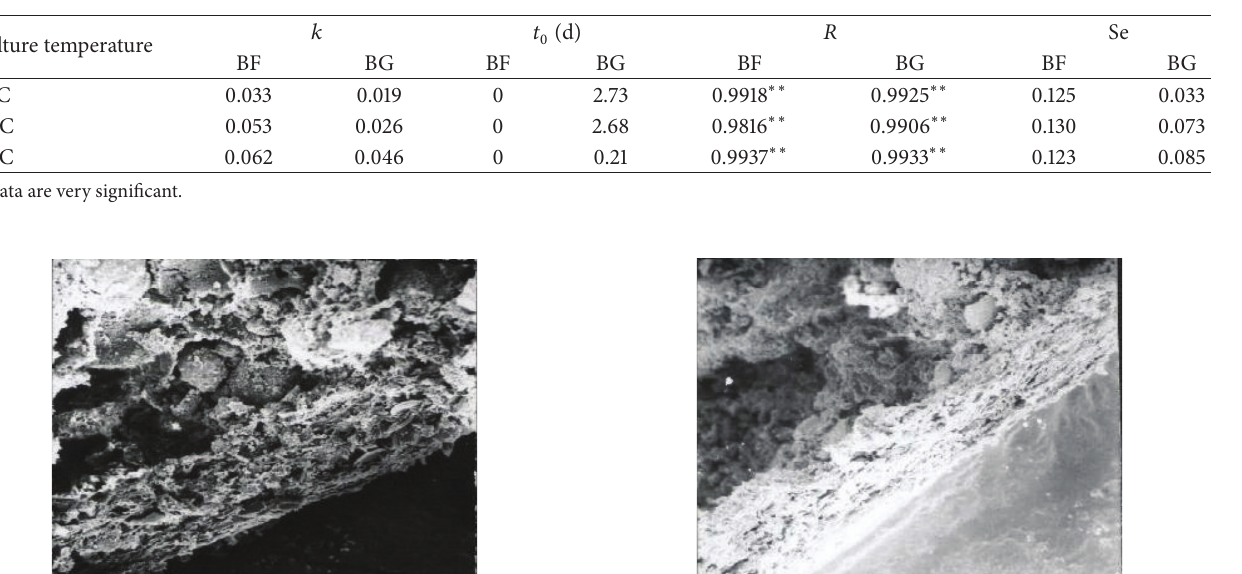
Table 1: Simulated first-order kinetic equation parameters for the nitrogen accumulated leaching rate in the BF and BG coated, slow-release urea.